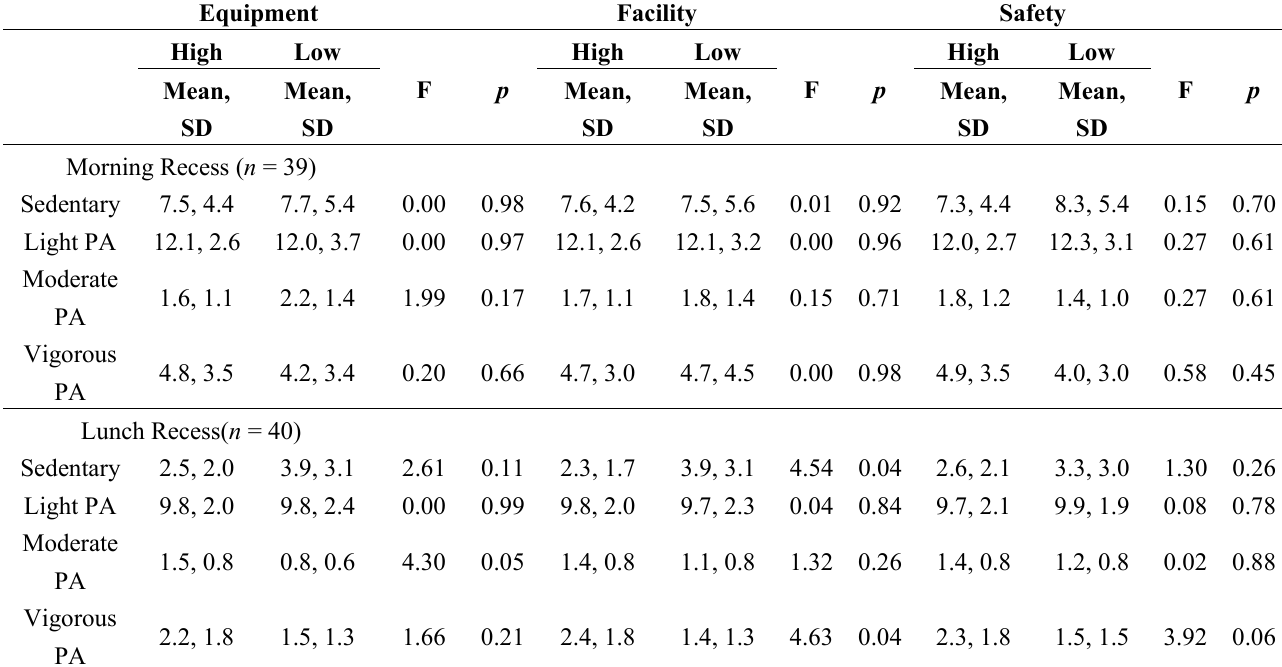
Table 2. Differences in recess physical activity according to perception of school environment (boys).